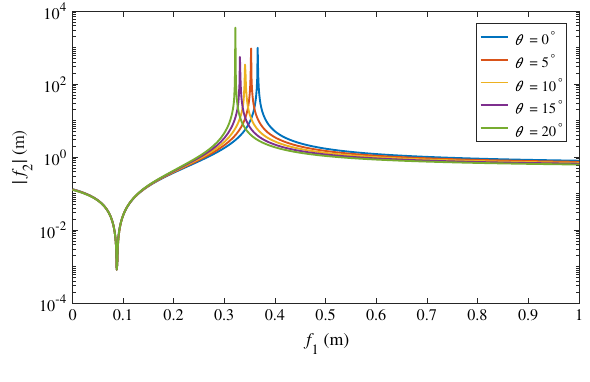
FIG. 3. Relation between f 1 and f 2